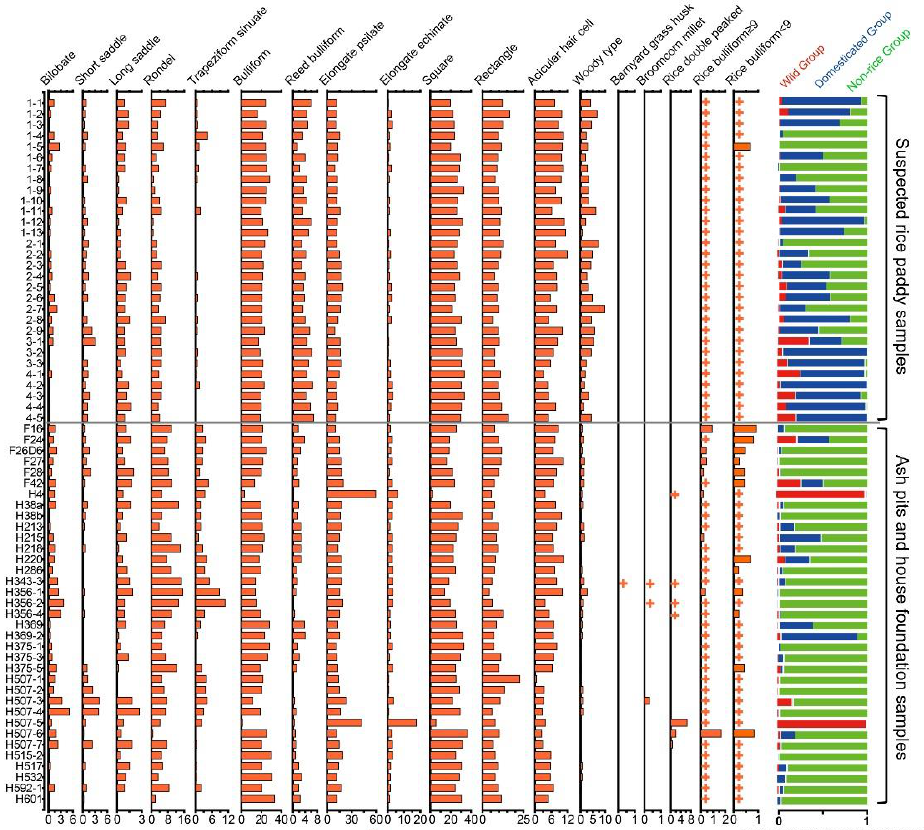
Figure 4. Percentages of the major phytolith types and results of the discriminant analysis at Zhang- wangzhuang. Cross symbols indicate the presence of the phytolith types that were insufficient to count in the phytolith assemblage.